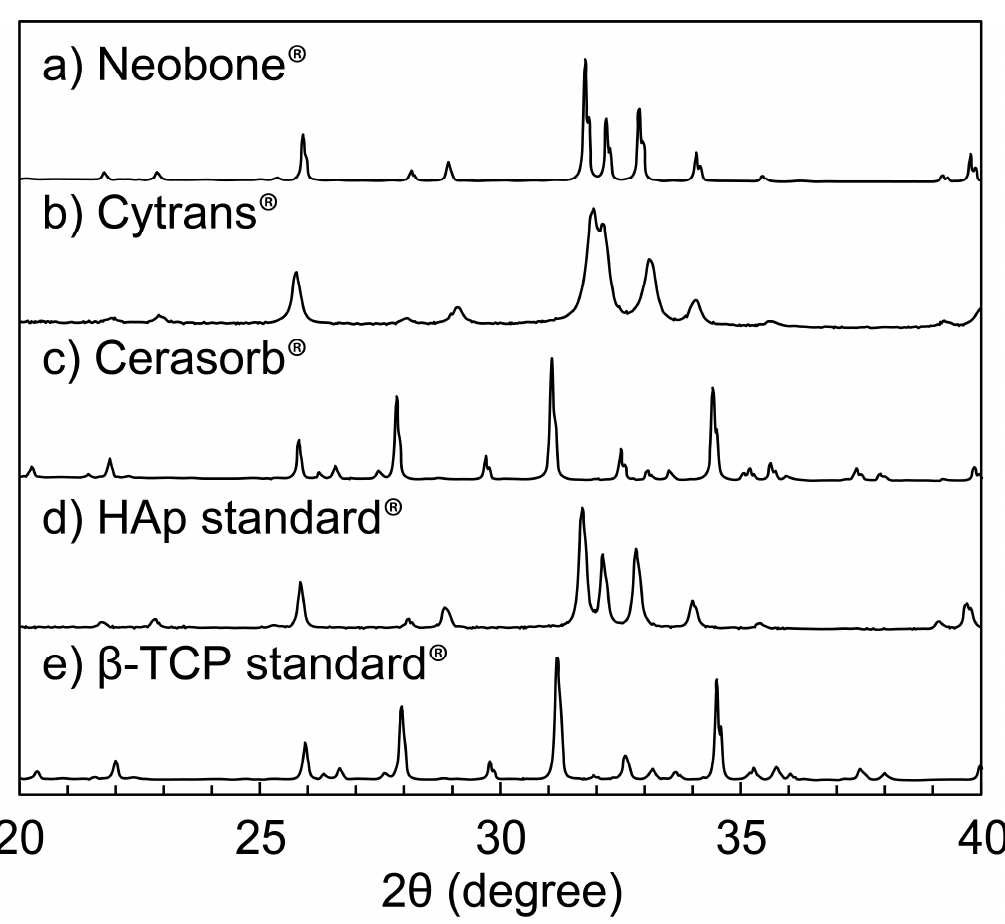
Figure 2. X-ray diffraction patterns of ( a ) Neobone ® (HAp), ( b ) Cytrans ® (CO 3 Ap), ( c ) Cerasorb ® ( β -TCP), ( d ) standard Hap, and ( e ) standard β -TCP.